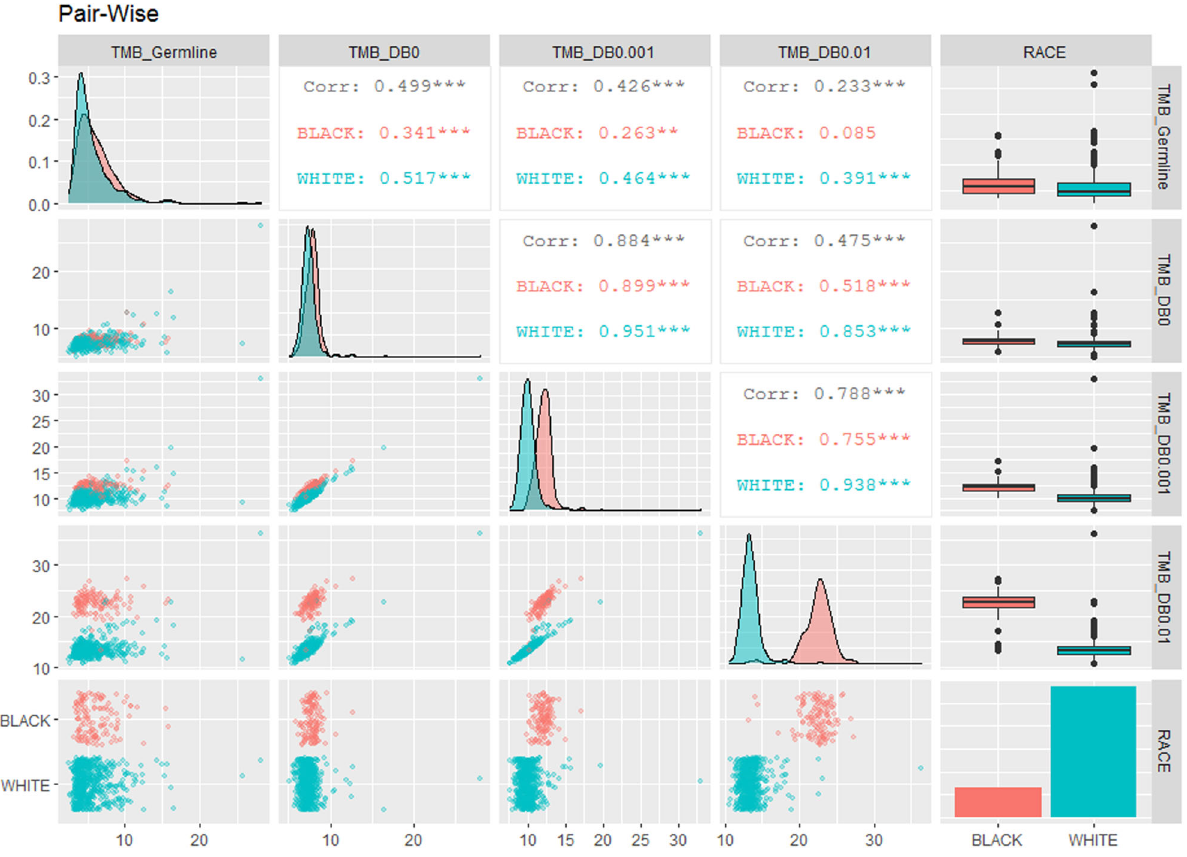
Fig. 2 Pair-wise visualization of the differences in tumor mutational burdens between race and variant fi ltering criteria. This is a 5 × 5 matrix of pair-wise comparison. Red colors are data from Black patients, and blue colors are data from White patients. (1) The diagonal: density plots showing the increased separation of TMB distributions while relaxing the non-somatic variant fi ltering thresholds from paired germline (TMB_Germline), to ascending variant MAFs in 1000G and ExAC (TMB_DB0: MAF = 0; TMB_DB0.001: MAF ≤ 0.1%; TMB_DB0.01: MAF ≤ 1%). The last diagonal plot (bottom right) is the bar plot of the counts of 126 Black and 575 White patients included in the analyses. (2) The upper right panels of correlation values: the Pearson Correlation r values of TMBs across patients. The black numbers are the r values of all 701 patients. The last columns of the upper right panels are the box plots of the TMBs from different fi ltering criteria. (3) The lower left panels of dot plots illustrate the individual TMB values per patient; and the last row of the lower left panels are the jittered-point bar plots of individual TMB